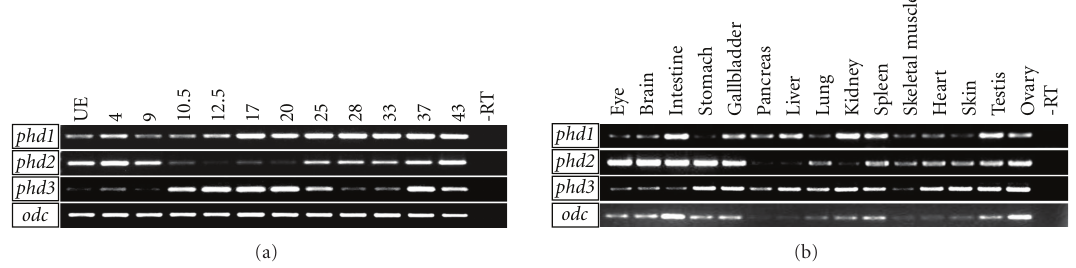
Figure 4: Temporal expression profile and adult tissue expression patterns of phd1 , 2 , and 3 revealed by RT-PCR analyses. (a) Temporal expression profile of phd1 , 2 , and 3 in Xenopus embryos. (b) Expression of phds in Xenopus adult tissues. odc was employed as a loading control. UE: unfertilized